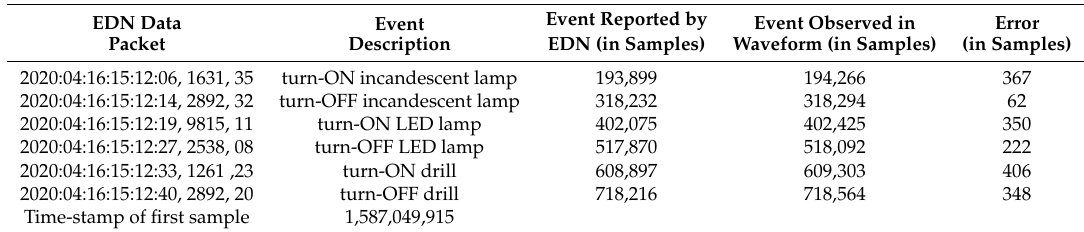
Table 16. Events representations